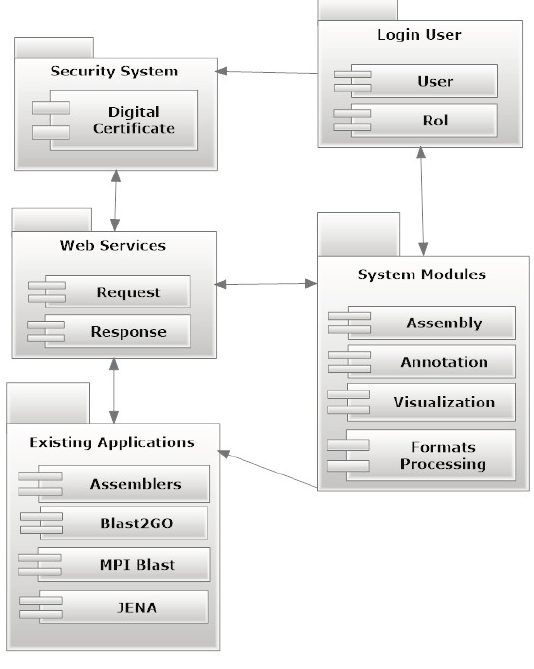
Figure 1: Main modules for